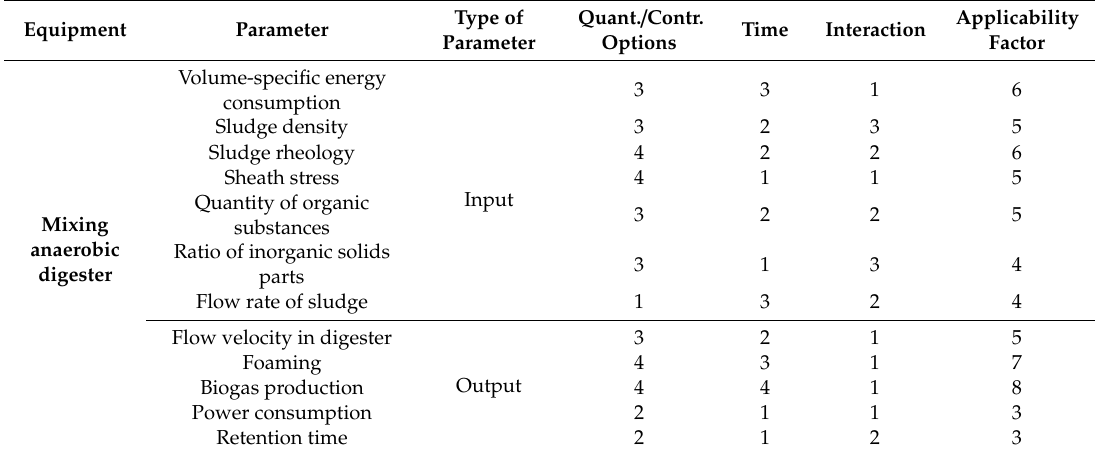
Table 11. Evaluation of parameters of the mixing of anaerobic digester.